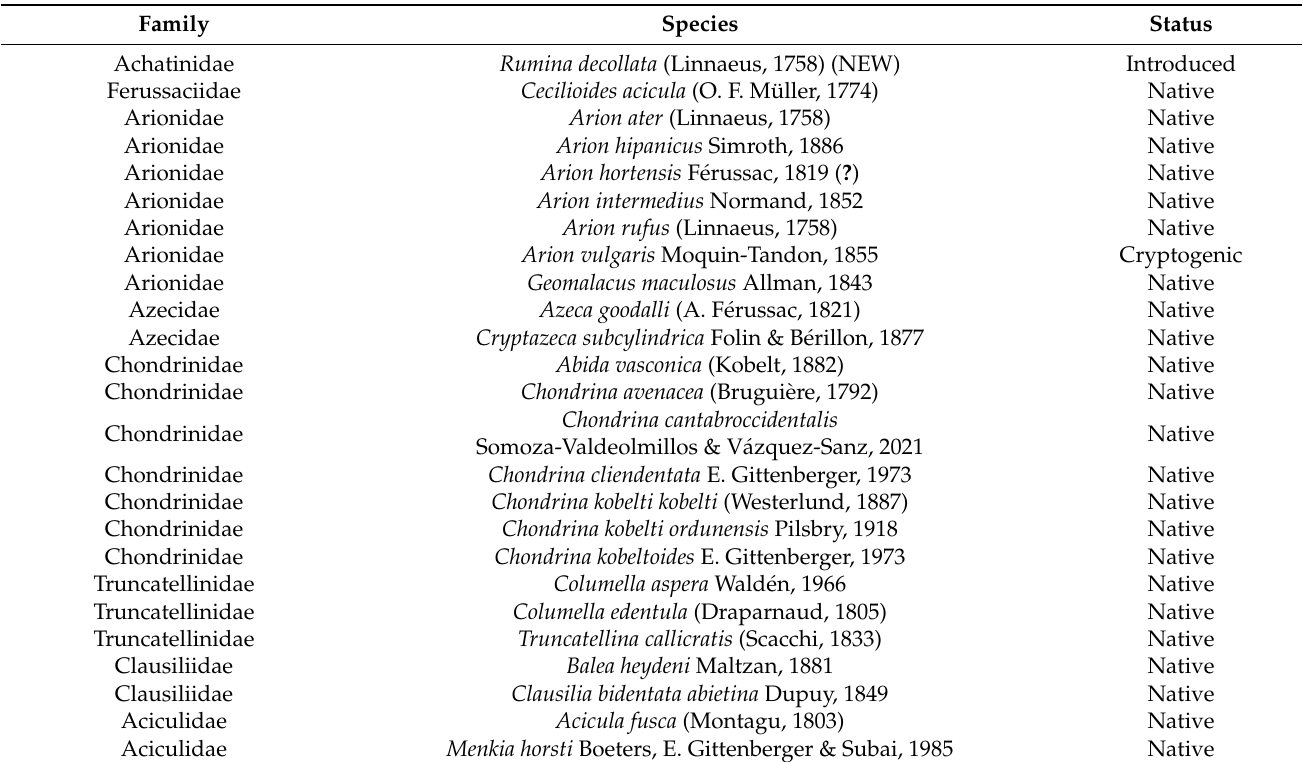
Table A2. Diversity of terrestrial molluscs of the Principality of Asturias. NEW: New record. ‘ ? ’: needs